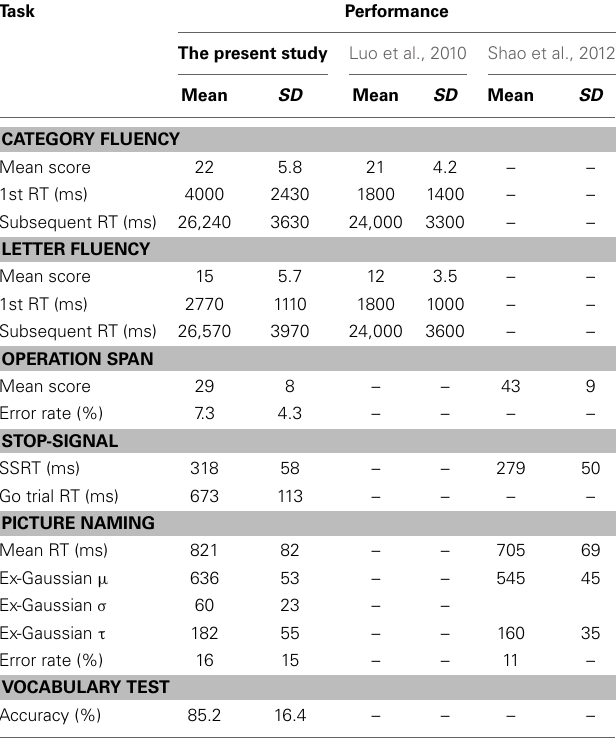
Table 1 | Mean score, the 1st reaction time (RT) and subsequent RT in the category and letter fluency task, mean score and error rate of operation span task, stop-signal RT (SSRT) and mean RT of go trials of stop-signal task, mean naming RT, ex-Gaussian parameters and error rate of picture naming